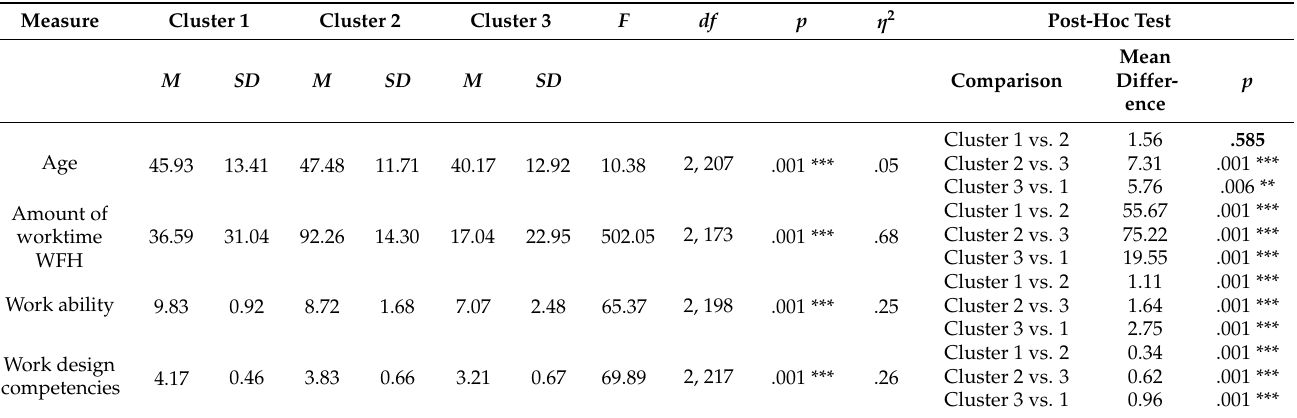
Table 4. Descriptive statistics of the test variables divided into clusters ( N = 369), analyses of variance, and post-hoc tests.